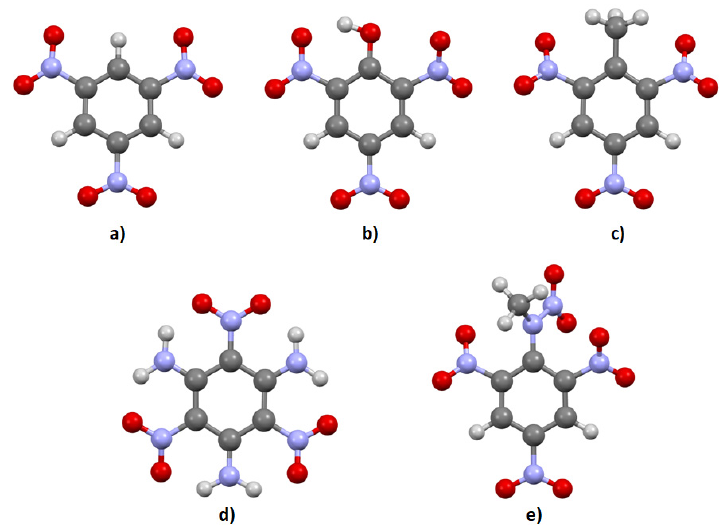
Figure 1. Optimized geometries of ( a ) 1,3,5-Trinitrobenzene (TNB), ( b ) 2,4,6-Trinitrophenol (TNP), and ( c ) 2,4,6-Trinitrotoluene (TNT), ( d ) 2,4,6-Triamino-1,3,5-trinitrobenzene (TATB) and ( e ) 2,4,6-Trinitrophenylmethylnitramine (TETRYL).